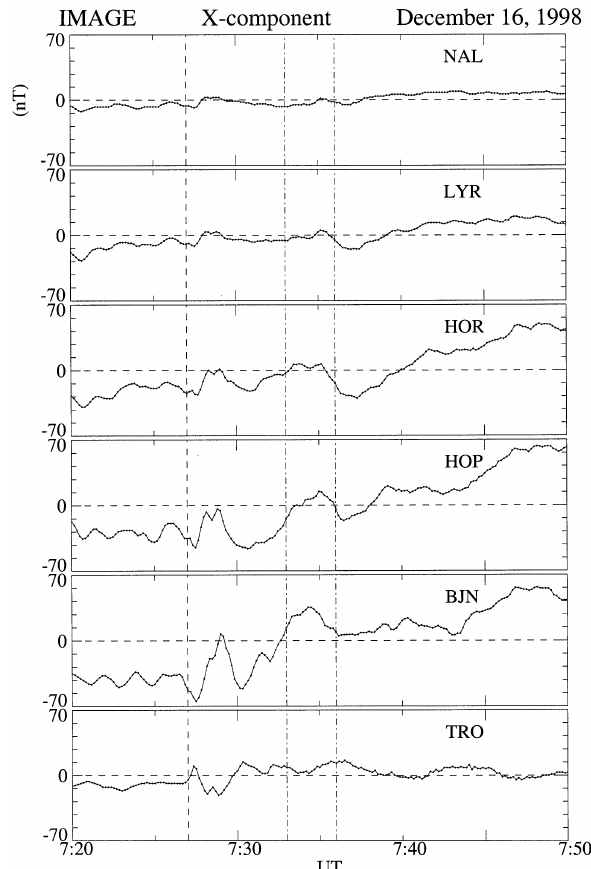
Fig. 7. X component magnetograms from IMAGE chain stations on Svalbard and at Tromsø (TRO) for the interval 0720–0750 UT. The station coordinates are: NAL (76.1 ◦ CGMLAT), LYR (75.1 ◦ CGMLAT), HOR (74.0 ◦ CGMLAT), HOP (72.9 ◦ CGMLAT), BJN (71.3 ◦ CGMLAT), TRO (66.5 ◦ CGMLAT). Magnetic impulse event at 0727 UT is marked by vertical dashed line, while the auroral arc/convection event we focus on is marked by vertical dash-dot lines at 0733 and 0736